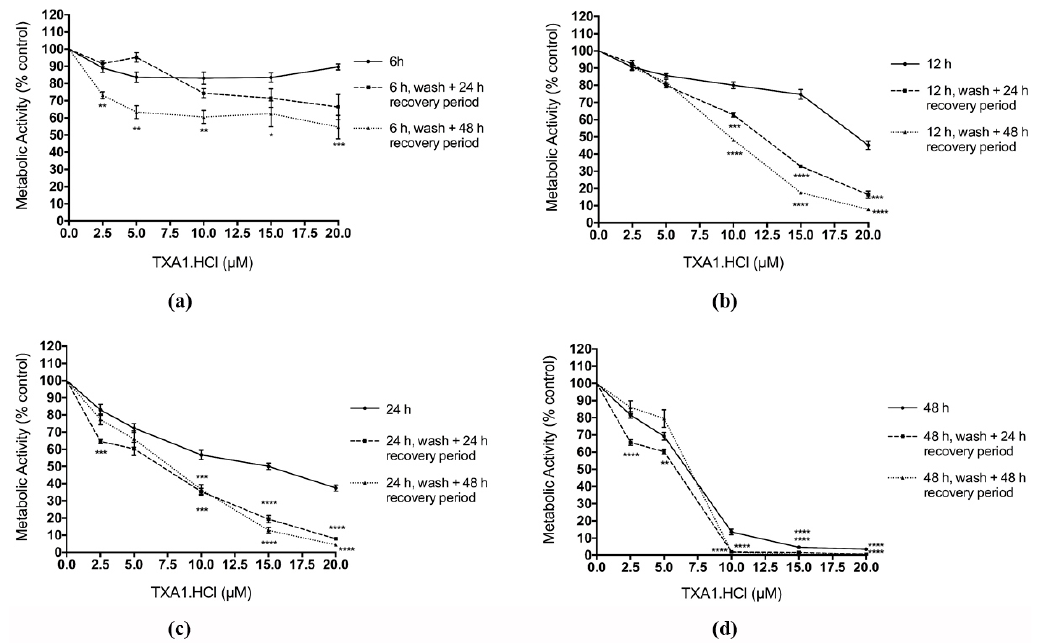
Figure 2. Analysis of the reversibility of the effect of TXA1·HCl in MCF-7 cells, analyzed with the MTT assay. Cells were treated with increasing concentrations of TXA1·HCl for 6 h ( a ); 12 h ( b ); 24 h ( c ) or 48 h ( d ) and then incubated for an additional 24 or 48 h in compound-free medium. Metabolic activity is expressed as percentage of blank (cells treated with medium only). Results are expressed as mean ± SEM from three independent experiments. * p ≤ 0.05; ** p ≤ 0.01; *** p ≤ 0.001; **** p ≤ 0.0001 when comparing treatment vs. control ( H 2 O).